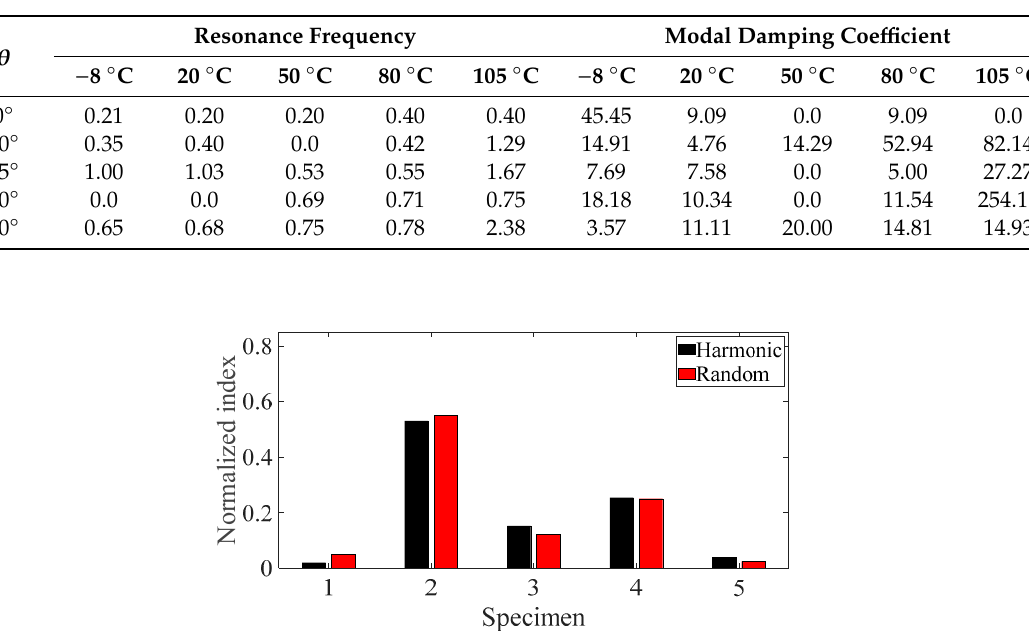
Table 8. Relative error in the first modal parameters (unit: %).